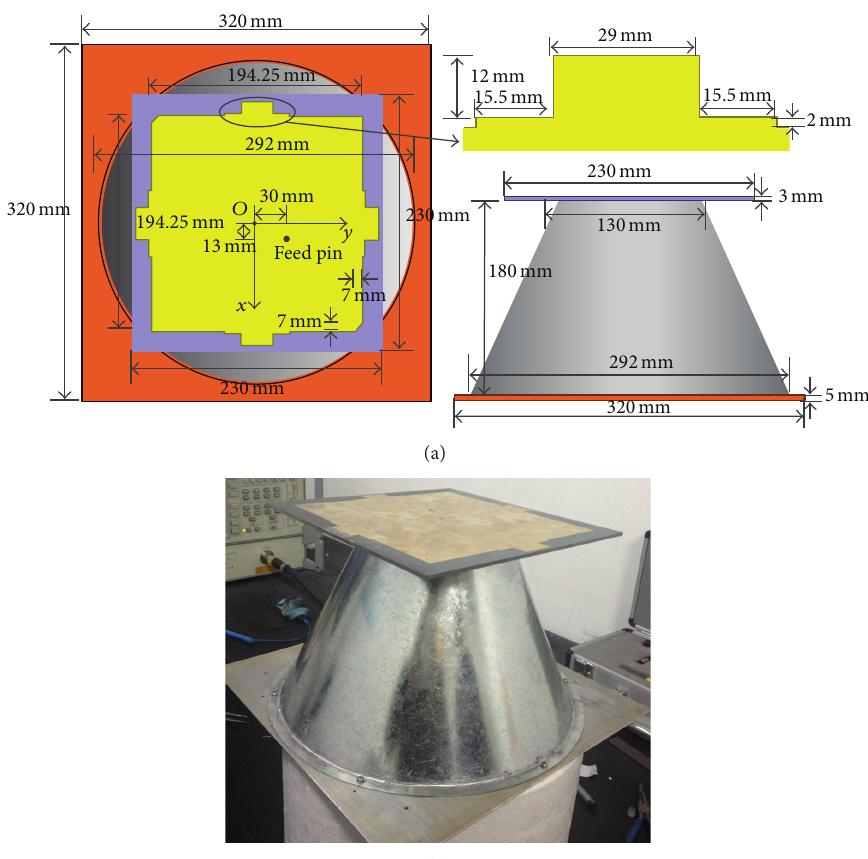
Figure 1: Configuration of the proposed RHCP antenna: (a) physical dimension (b) experimental prototype.